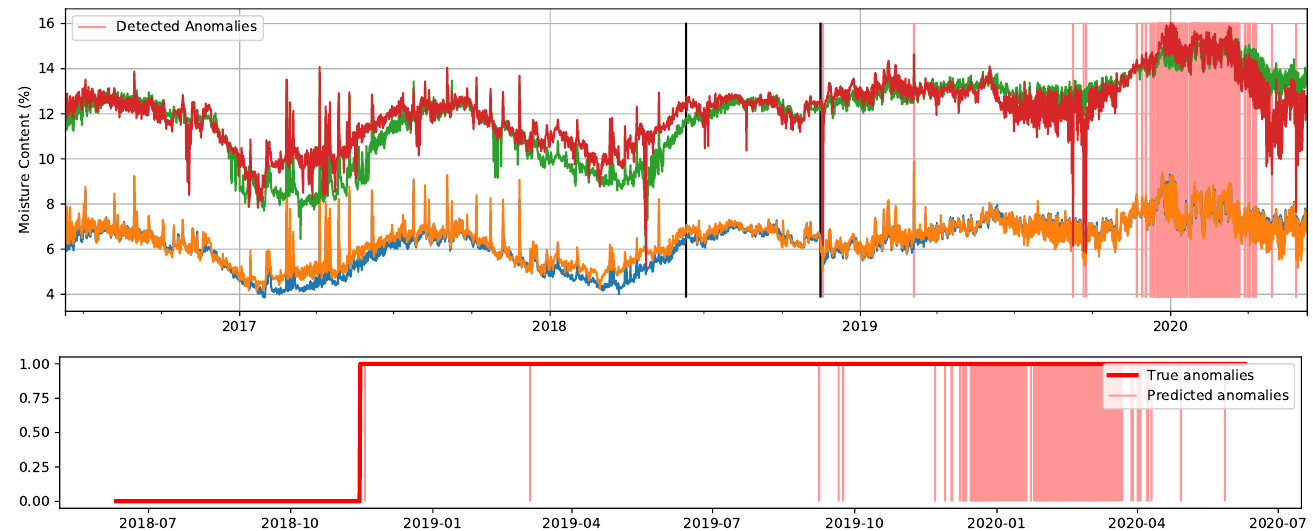
Figure 14. Detected anomalies when using the cluster-based LOF method with the original signals and a thresholding contamination value of 10%. Predicted anomalies are marked in light red. In the top figure, two black lines determine the start of the test set and, afterwards, the moment when the A/C failed. In the bottom figure, corresponding only to the test set, true anomalies are delimited by the red line.